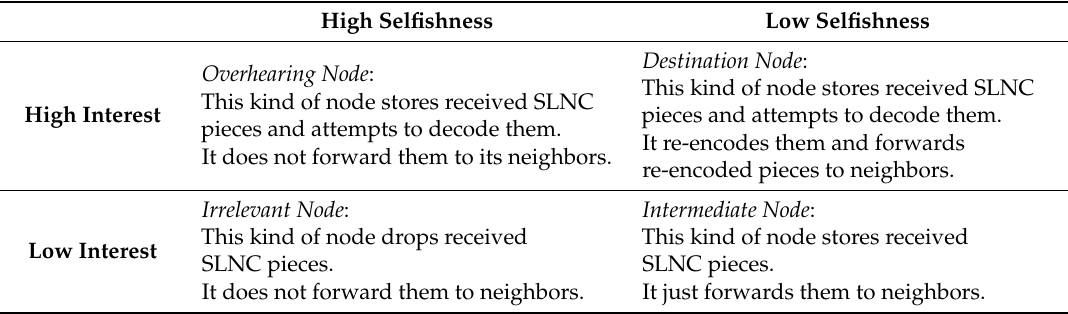
Table 2. Definitions and operations for four types of vehicular